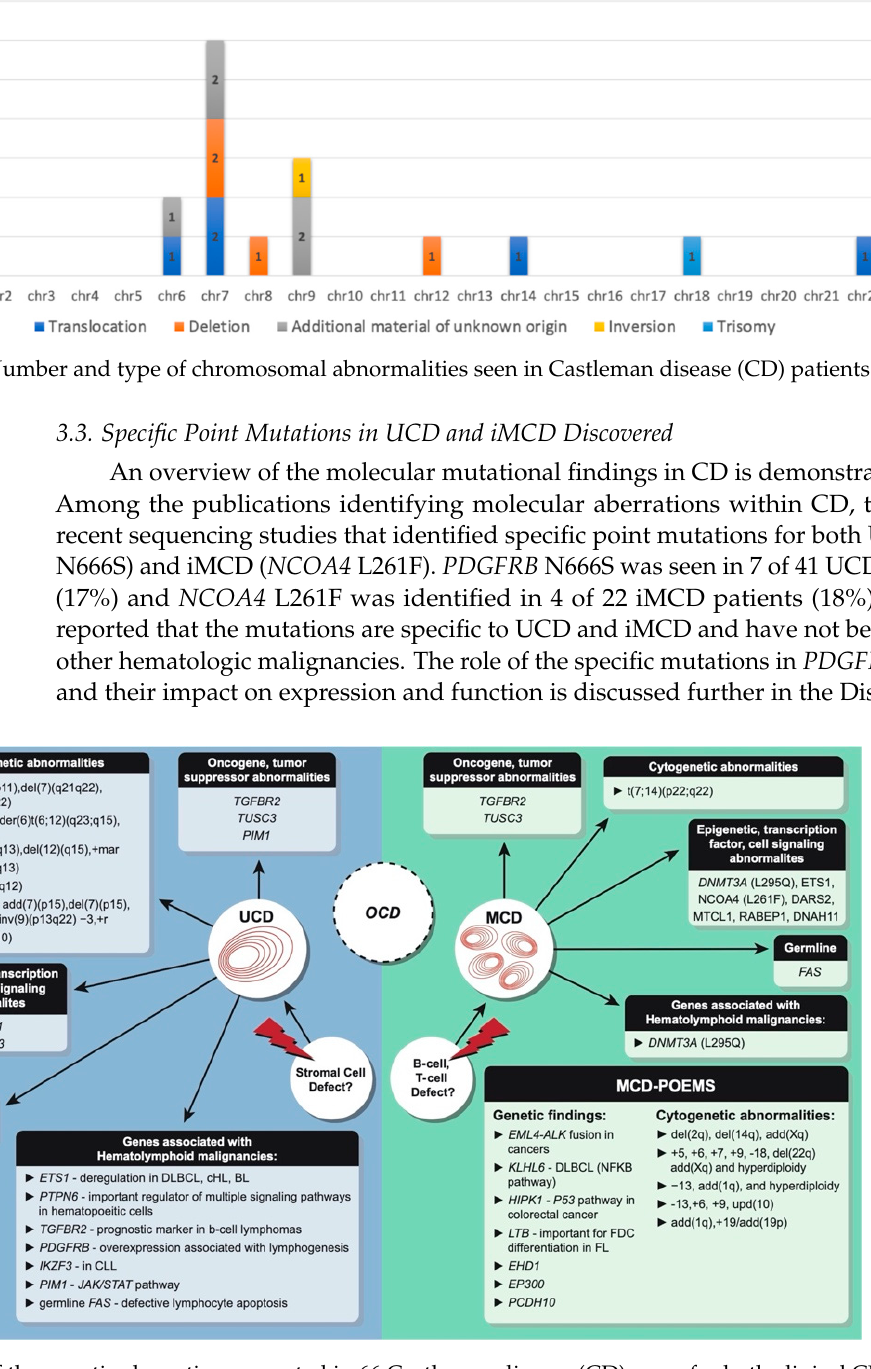
Figure 3. Overview of the genetic aberrations reported in 66 Castleman disease (CD) cases for both clinical CD subtypes. Key: OCD, oligocentric Castleman disease; UCD, unicentric Castleman disease; iMCD, idiopathic multicentric Castleman disease; POEMS, polyneuropathy, organomegaly, endocrinopathy, monoclonal gammopathy, and skin change; HHV-8, human herpes virus 8; DLBCL, diffuse large B-cell lymphoma; CHL, classic Hodgkin lymphoma; BL, Burkitt lymphoma; CLL, chronic lymphocytic leukemia; FDC, follicular dendritic cell; FL, follicular